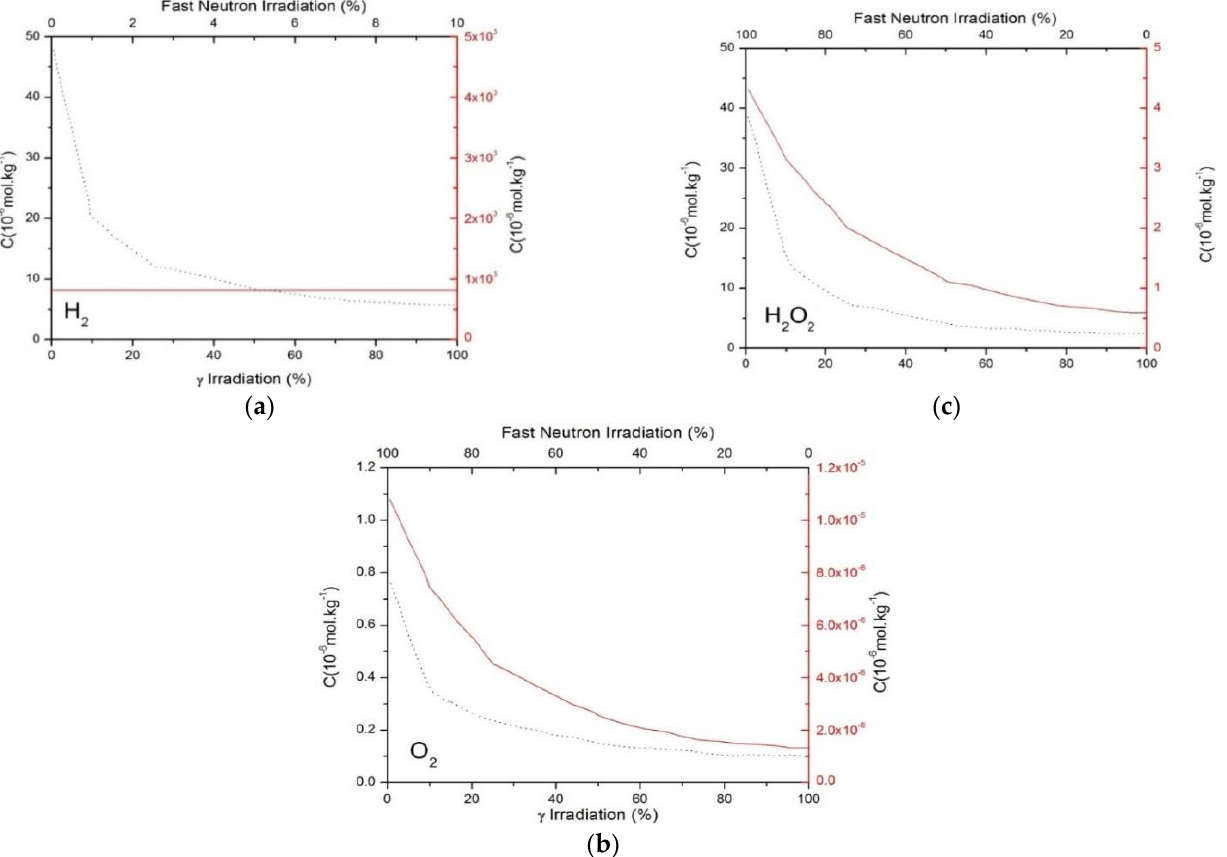
Figure 22. Predicted effect of mixed irradiation (fast neutrons + γ -photon) on the steady-state concentrations of ( a ) H 2 , ( b ) O 2 , and ( c ) H 2 O 2 under NWC (.......) and HWC (-------) at 250 °C, dose rate = 10 kG/s (after Kritsky et al. [27]). © 2001 ITER Organization. This image is hereby used courtesy of the ITER Organization.